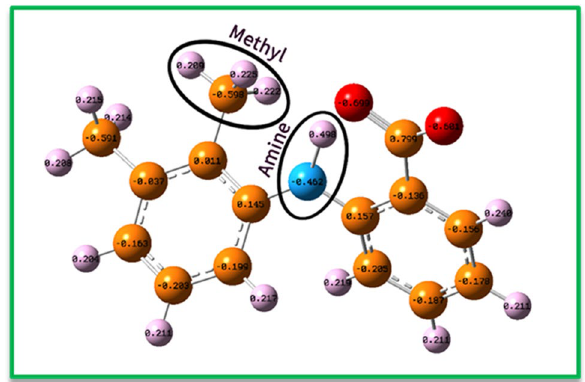
Figure 13. The natural charge distribution of MFA at B3LYP/6–311 + G (2d, p) level of theory.